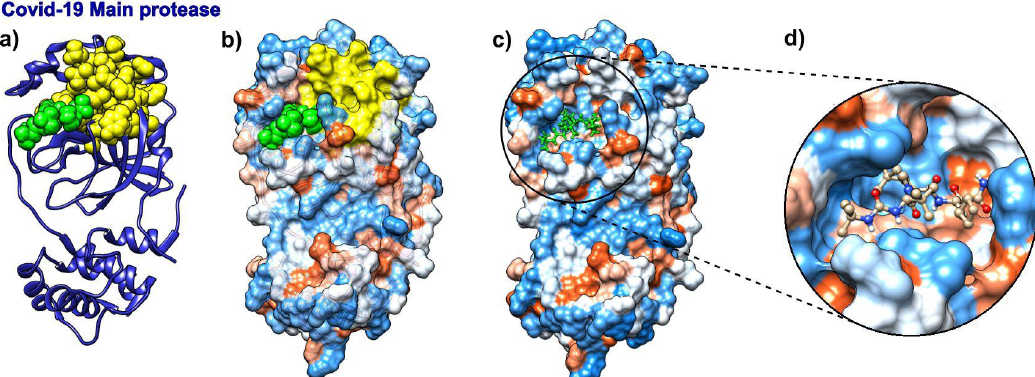
Figure 6. Boceprevir and its target protein COVID-19 (SARS-CoV-2) main protease (pdb id 6wnp). ( a ) COVID-19 Main protease is depicted as a blue ribbon, SAGNM predictions are yellow, and boceprevir as green atoms. ( b ) COVID-19 main protease is depicted as a transparent hydrophobic surface, SAGNM predictions are yellow, and chloroquine is a green molecule. ( c ) COVID-19 main protease is depicted as an opaque hydrophobic surface, and chloroquine is depicted via green balls and sticks. ( d ) The inset shows boceprevir inside the binding pocket.